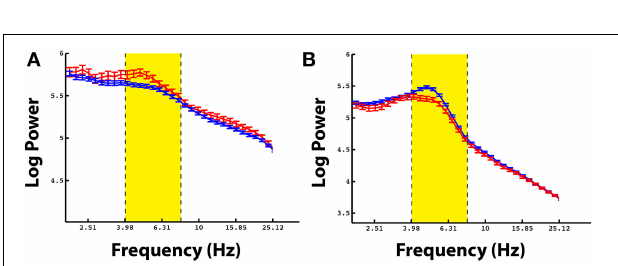
box marks the theta frequency range. The horizontal lines mark the p = 0.05 significance level. (B) The histogram displays the number of electrodes that showed a statistically reliable ( p < 0.05) modulation of power during the post-stimulus interval. The horizontal line shows the number of electrodes that should be expected to be significant by chance at the p = 0.05 level. Panels (C,D) show identical plots for the pre-stimulus interval (0–1000ms).